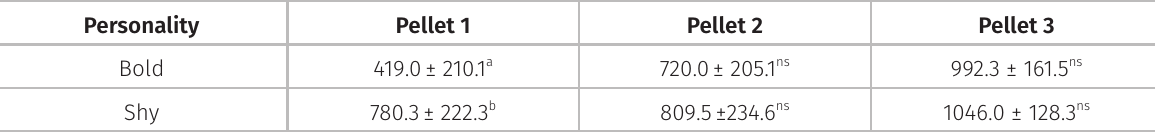
Means with diferente letters in the same column indicate a significant difference by the T test ( p < 0.05). ns: not